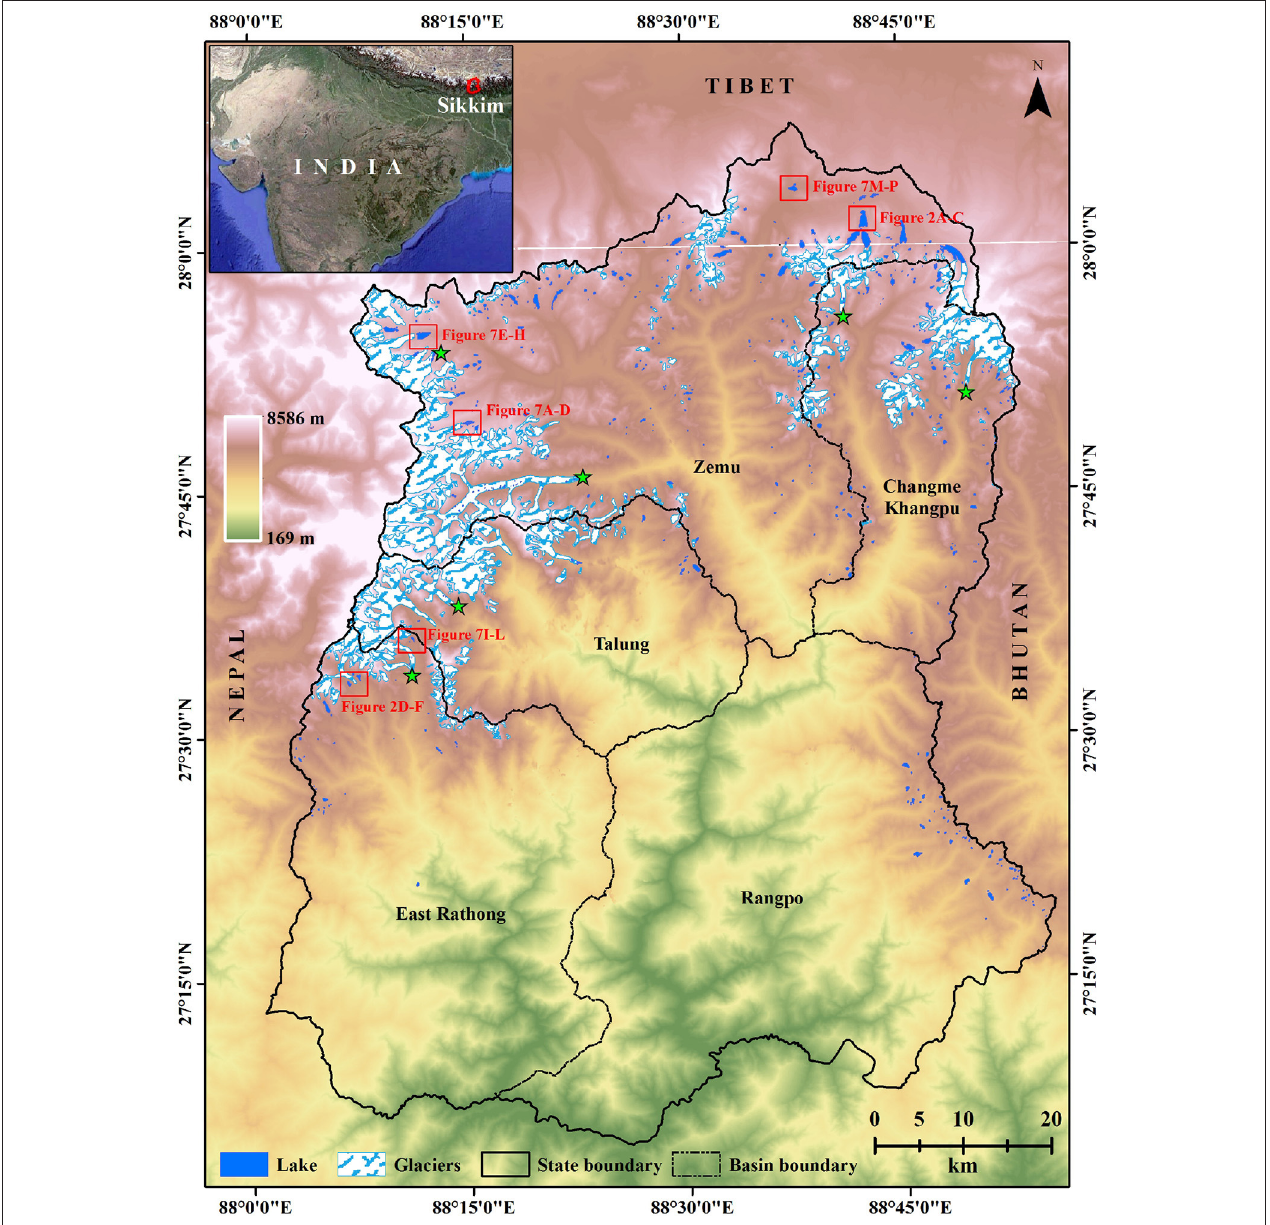
FIGURE 1 | Location map of study area. The glacier polygons overlain on image are derived from GLIMS inventory. The lake polygons shown in the map are of the year 2000, mapped using Landsat ETM + image. The red rectangles display the location of lakes shown in Figures 2 , 7 . The star marks show the location of glaciers included in annual mapping of supraglacial lakes